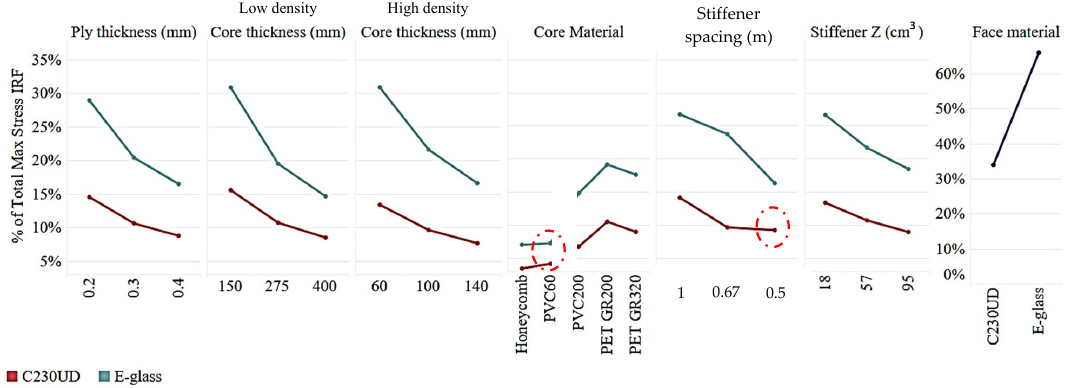
Figure 13. Sensitivity analysis of parameters for stiffened sandwich panel stress safety factor.